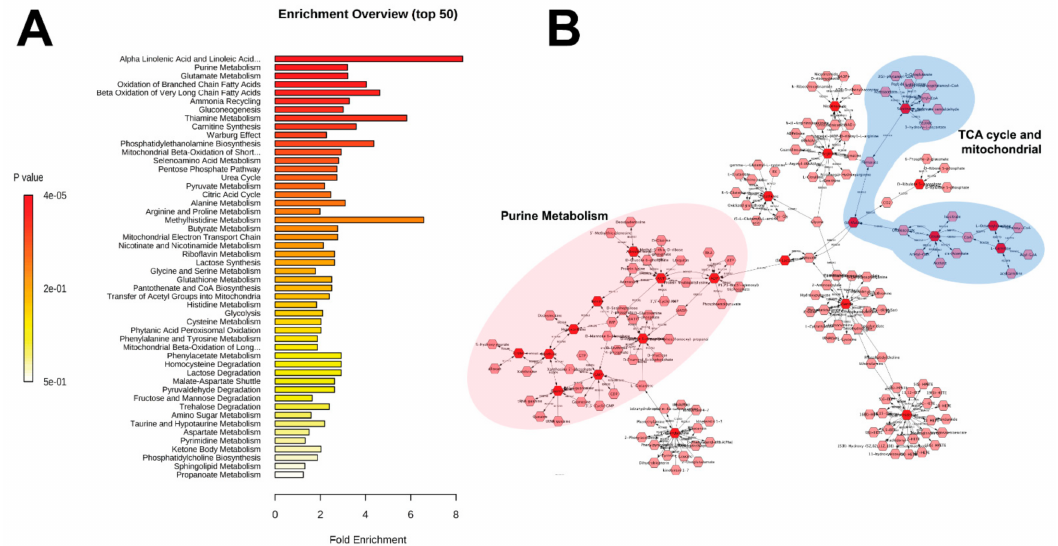
Figure 3. ( A ) Enrichment analysis of the MS/MS identified metabolites. Fatty acids and purine metabolism are prominently enriched. ( B ) Metscape analysis of metabolites (excluding fatty acids) demonstrates the connection between purine metabolism and tricarboxylic acid (TCA) cycle/mitochondrial metabolites. Dark red hexagons signify metabolites that were positively identified through